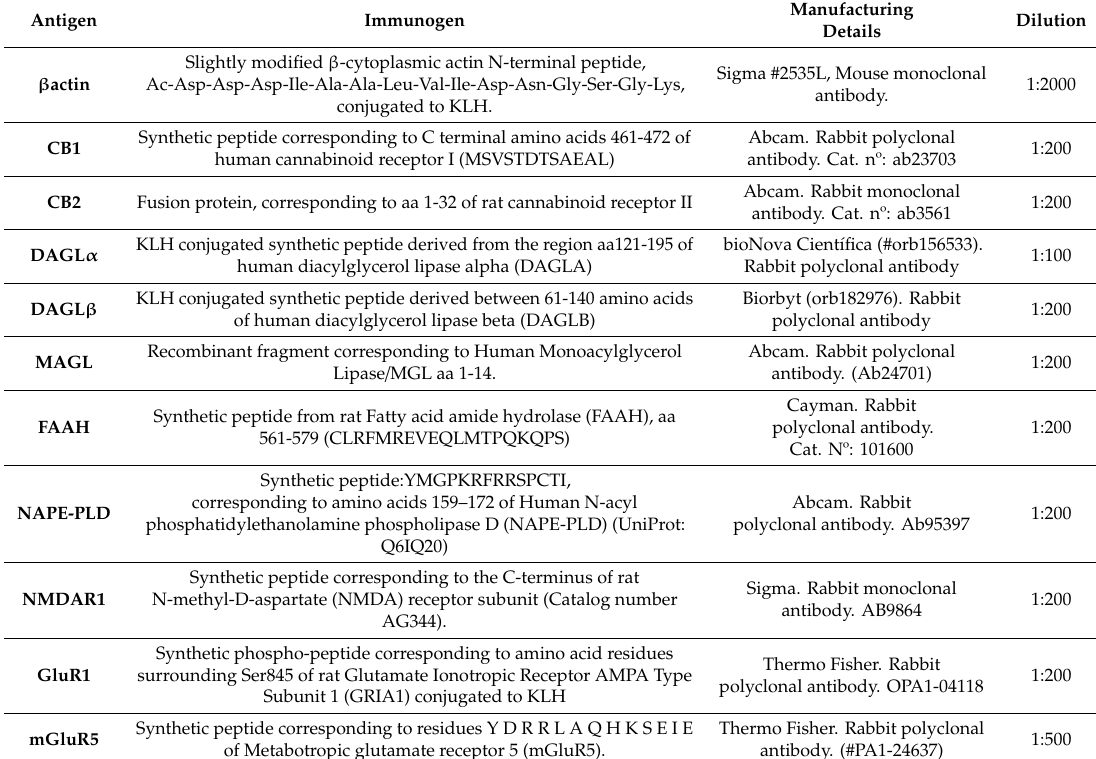
Table 3. Antibodies used for protein expression by Western